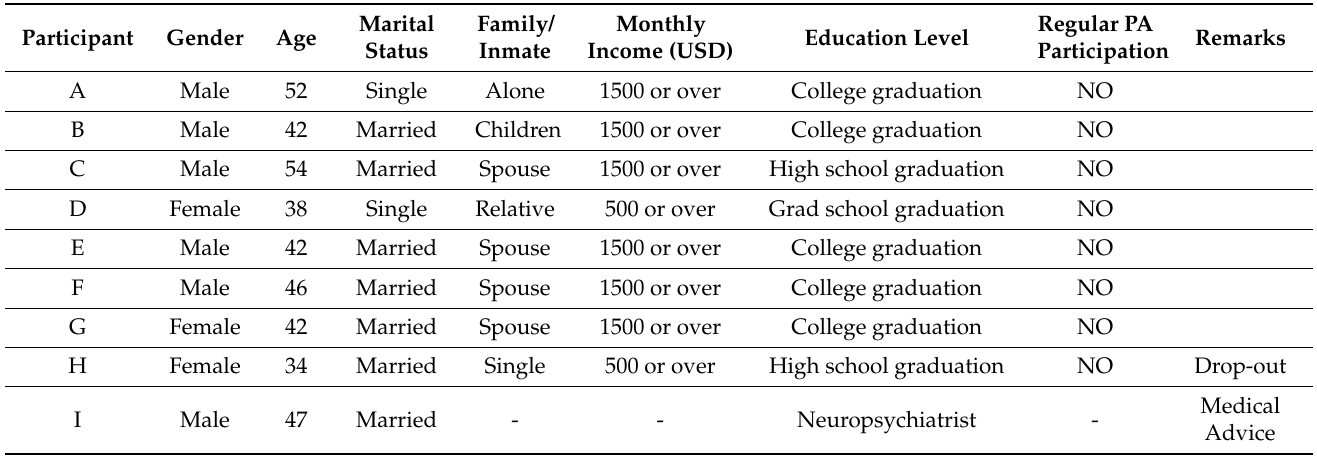
Table 1. General characteristics of